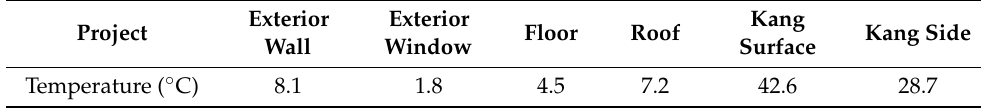
Table 4. Wall temperature boundary condition for ventilation dilution simulation.